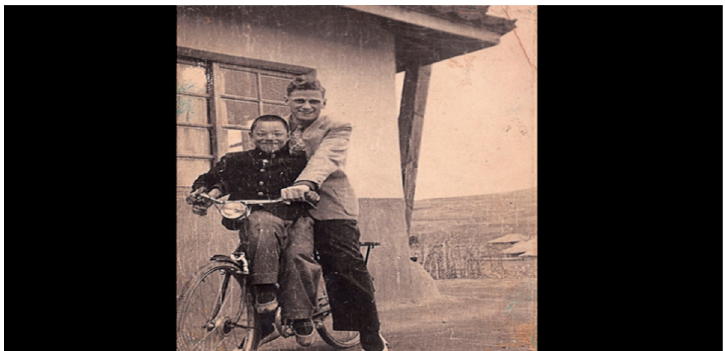
Figure 1. Park Ock Soo with Kays Glass, public domain.